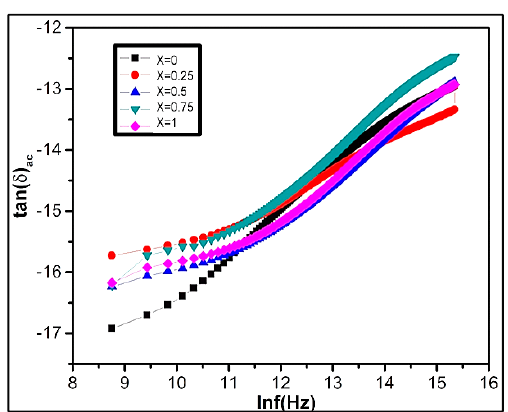
Figure 7. The variation of dielectric loss tangent tan(δ) as a function of lnf(Hz) of Ni 1-x Zn x Fe 2 O 4 . Figure 8. Graphical representation of the variation of tan Ϭ ac conductivity lnf(Hz) of Ni 1-x Zn x Fe 2 O 4 .